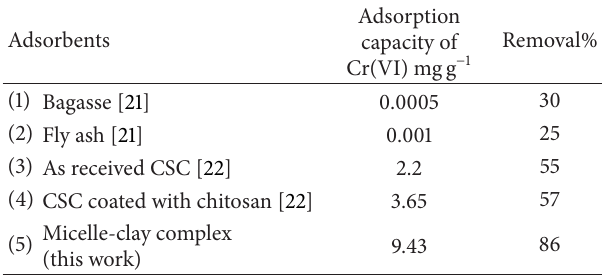
Table 2: Comparison between the efficiencies of different low cost adsorbents towards removal of Cr(VI) at pH = 6 and temperature = 25.0 ± 0.2 ∘